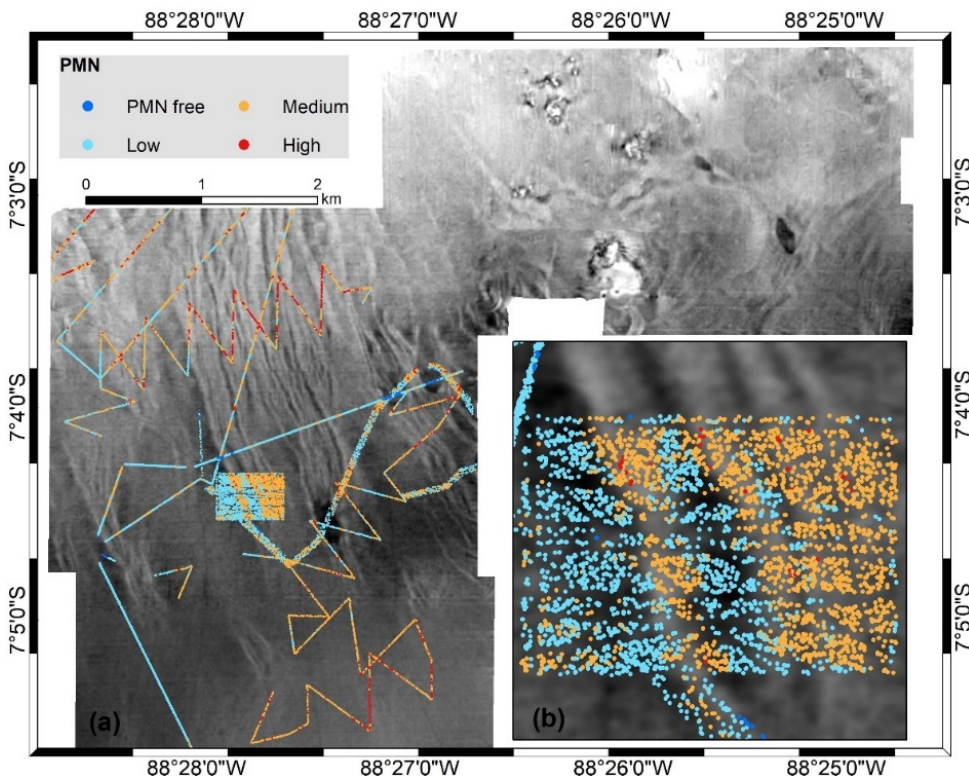
Figure A4. ( a ) PMN distribution within the study area (DEA). ( b ) The central part of the area is characterized by successive alternations of higher and lower numbers of PMN. These alternations seem to follow the abyssal furrows microrelief. The background map is the backscatter intensity, with brighter areas to imply higher reflectivity. A higher-resolution map of PMN distribution inside the photomosaic area is provided by [9].